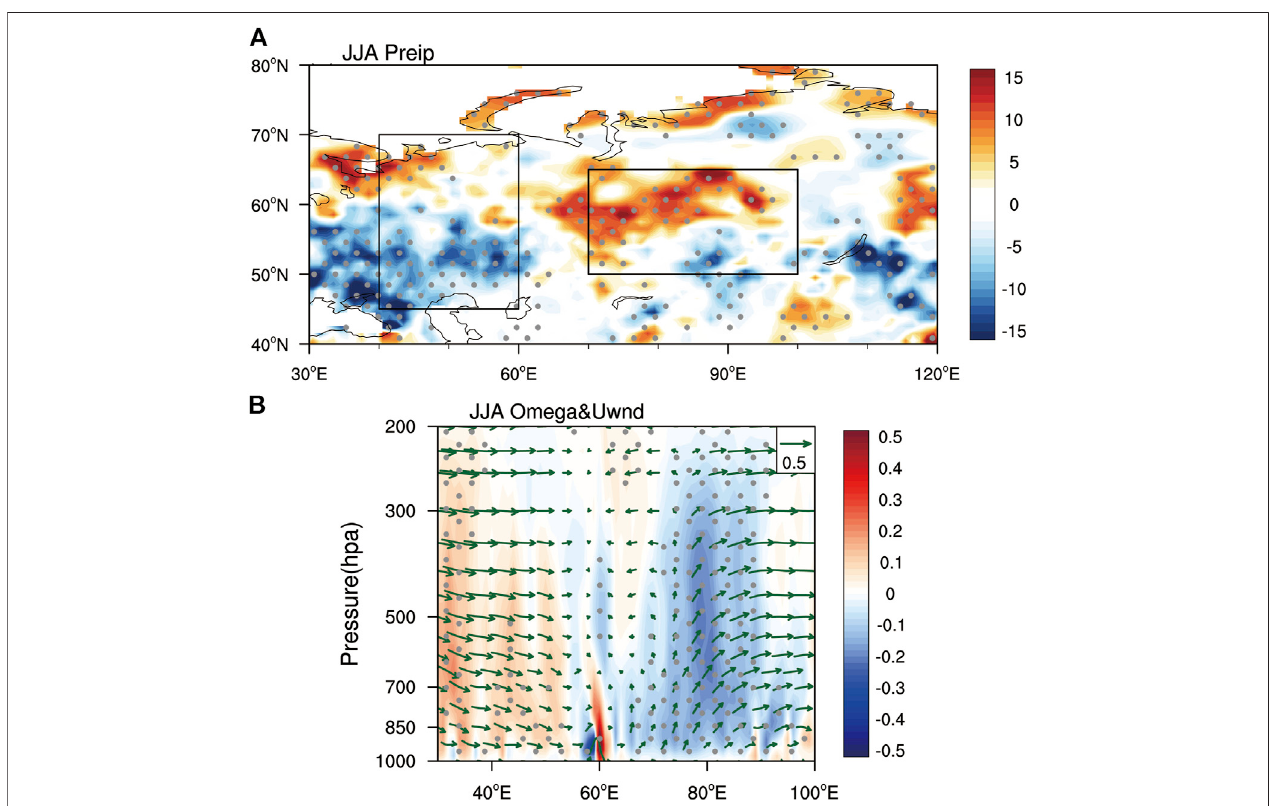
FIGURE6| Summer(JJA) (A) precipitation(mm)and (B) longitude-pressurecross-sectionofverticalvelocity(Pas − 1 )averagedalong55 ° – 65 ° Nregressedontothe SSDI. The black rectangles in (A) are the same as Figure 1A , and the stippling denotes the regression coef fi cients statistically signi fi cant at the 95% con fi dence level.